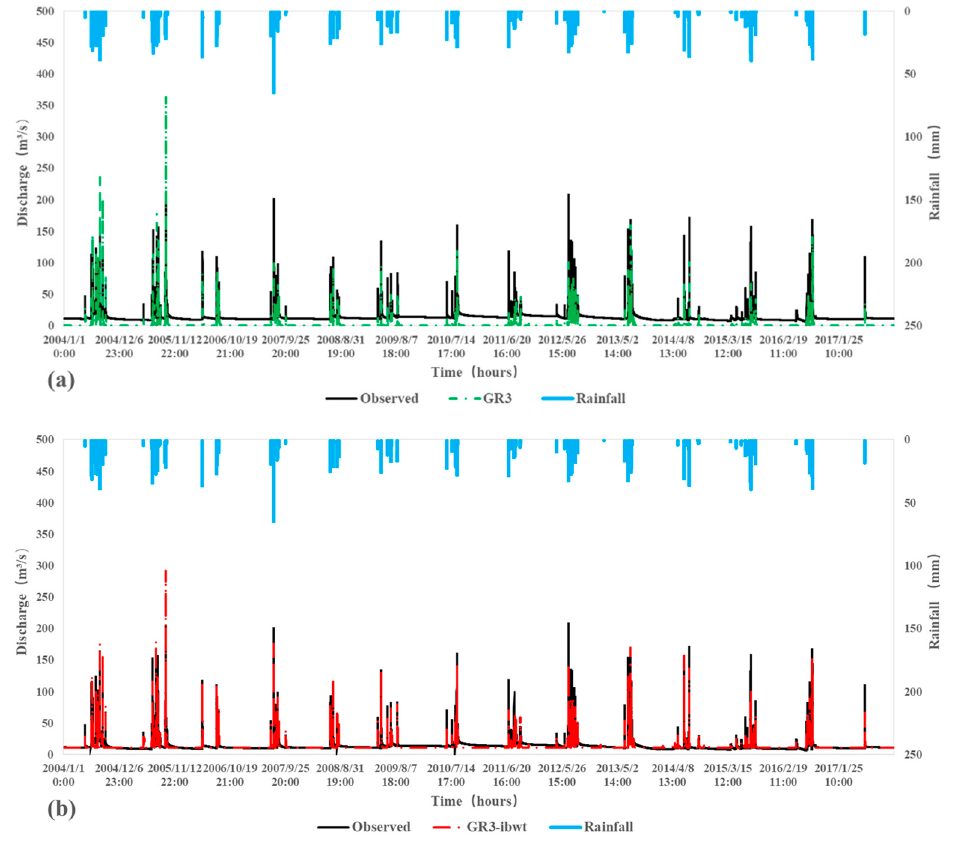
Figure 5. Time history of discharge at the outlet gauging station in long time series. ( a ): GR3 vs. observed; ( b ): GR3-ibwt vs. observed. Table 4. The statistical analysis of the measured and simulated discharge in long time series .